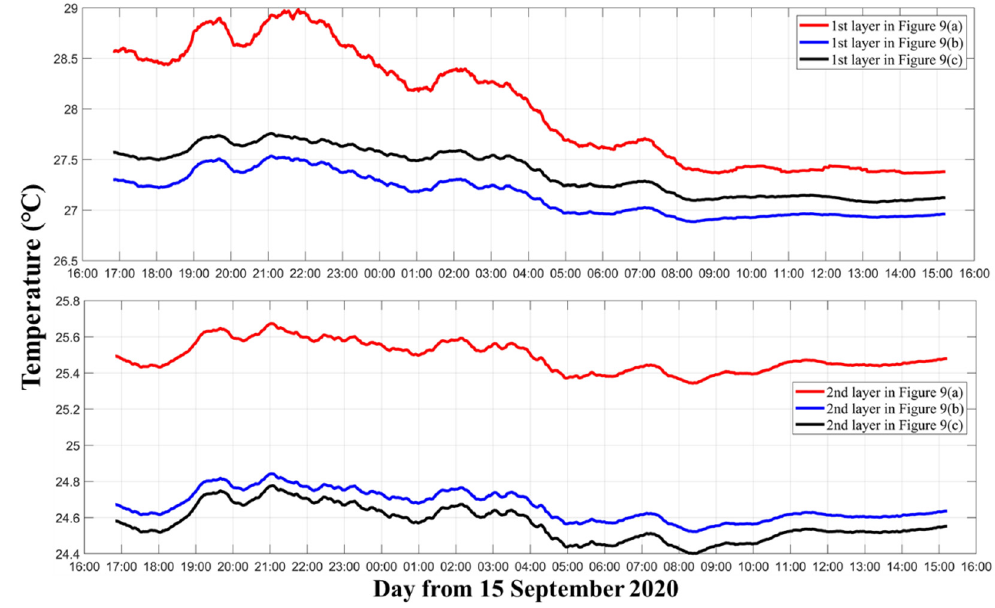
Figure 10. Moving average of the two layers’ temperature. The red, blue, and black curves indicate the two layers’ temperatures corresponding to Figure 9a–c, respectively.